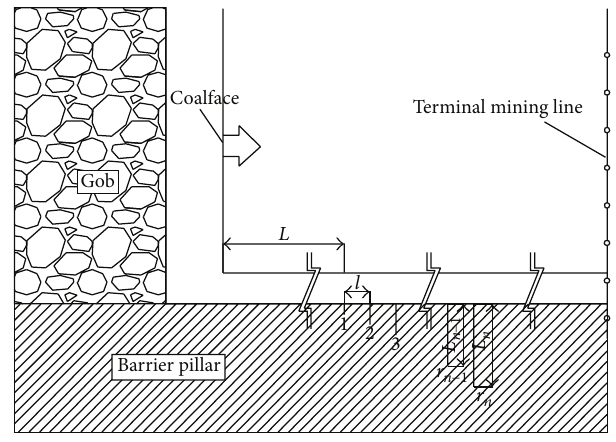
Figure 1: Layout of the side abutment stress observation station. 𝐿 represents the distance of the first borehole stress-meter to the coalface, which should be larger than the scope of influence of the front abutment stress; 𝑟 𝑛 represents the number of the observation station; 𝐿 𝑛 represents the length of the borehole stress-meter, which is in general 1 ∼ 2m; 𝑙 represents the space between the boreholes, which is in general 2 ∼ 3 m.